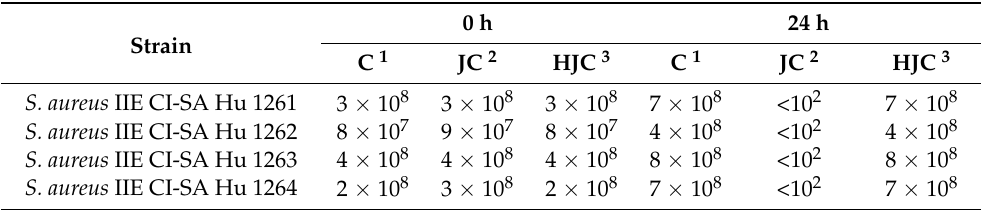
Table 3. Antagonistic activity of LF3872 against S. aureus isolated in humans from the nasopharynx and oral